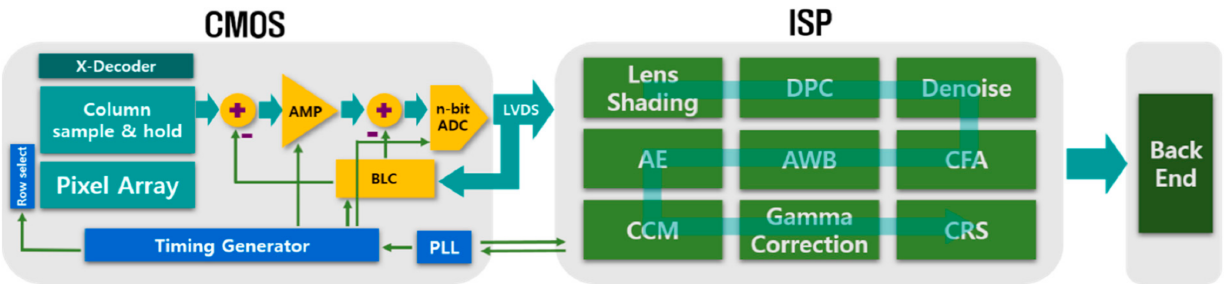
Figure 2. Conventional Structure of CMOS Image